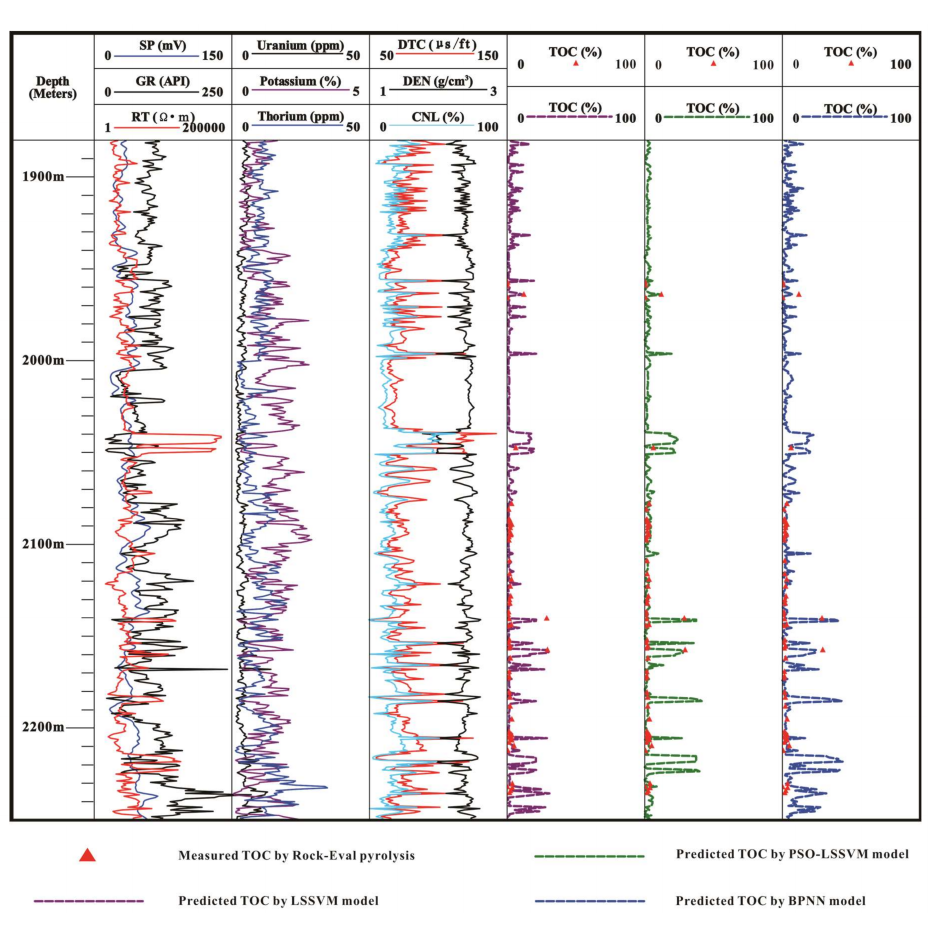
Figure 9. Geophysical logging data of Well E1 and the comparison of the TOC prediction results with the prediction models.